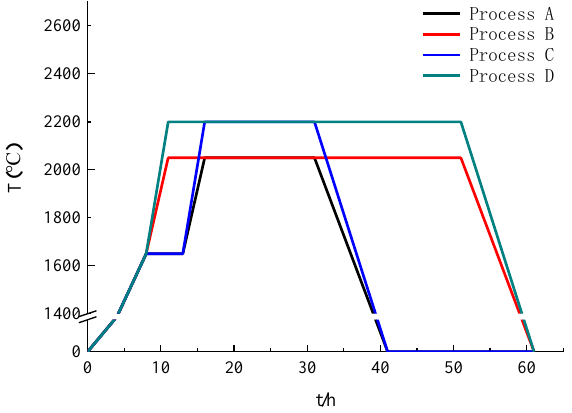
Figure 3. Curves of four processes. The state of raw materials after heat treatment by all four groups of purification processes is shown in Figure 4. Before processing, the SiC powder appeared as a green powder. After heat treatment in process A, the color of the powder turned dark green, and it was sintered from irregular particles into a massive solid, which was not very hard and could easily shed a few particles. In contrast, by prolonging the high-temperature period in process B, the powder color after heat treatment was significantly changed. The surface area became gray due to SiC graphitization, while the internal area was dark green with a hard block structure. In contrast, the powder was sintered into a ceramic state, and almost no SiC powder could fall off after process B. After heat treatment in process C, the color of the powder became dark green, which was darker than that in process A. The powder was sintered from irregular particles into a massive solid plate. There was a slight black graphitization phenomenon on the surface, and the powder was heavily ceramicized. The outer layer of the SiC powder after process D was seriously graphitized, while the porosity became larger. As the depth of the graphite layer increased, the outer layer of graphite became loose, which could be easily separated from the inner ceramic body. Compared with process B, the available volume of the ceramic parts in this scheme was smaller.